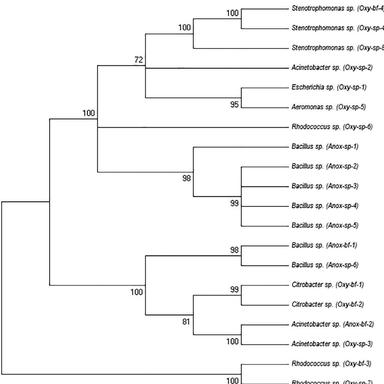
16S rDNA gene-based correlation of bacterial isolates. Isolated strains, catalogued according their original compartment and numbered (between brackets), were classified at the genus level according to BLAST interrogation and phylogenetic analysis. Phylogenetic tree was obtained through neighbor-joining. Numbers at the branch nodes indicate the bootstrap percentage values obtained from 1000 re-samplings (only values ≥70% are shown).